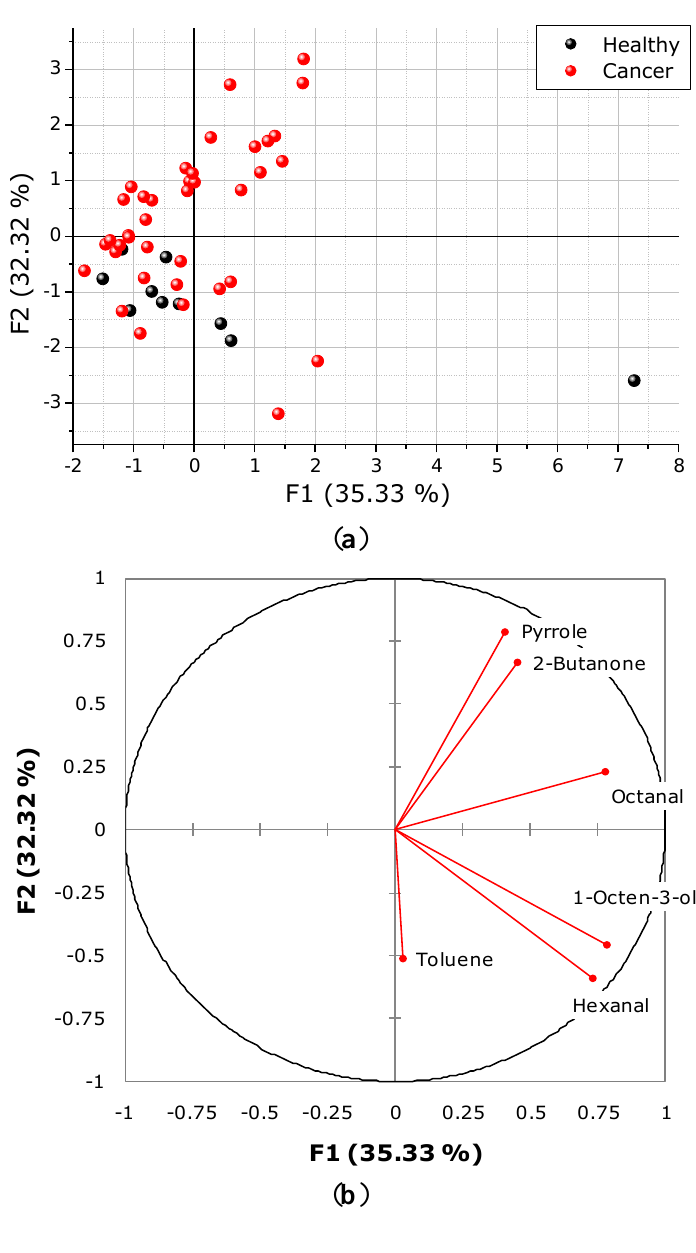
Figure 4. ( a ) PCA of the PC1 and PC2 values (F1 and F2) resulting from statistical analysis of the abundance of volatile organic compounds determined by TD-GC-MS analysis of dog plasma samples, using volatile compounds observed in both healthy and cancer samples. ( b ) loading chart indicating the contribution of the variables in total variability of first two principal components (F1 and